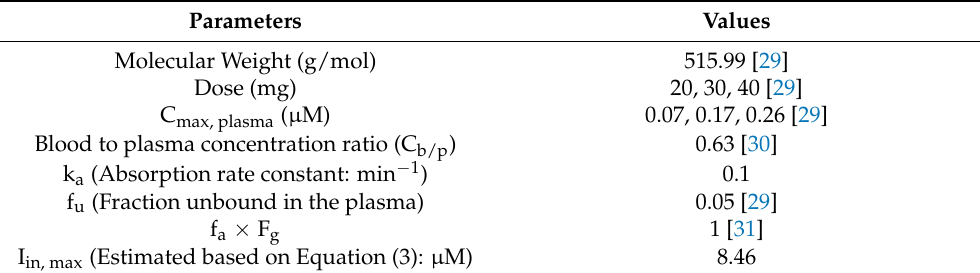
Table 1. Summary of nicardipine parameters for R-value determination. Parameters